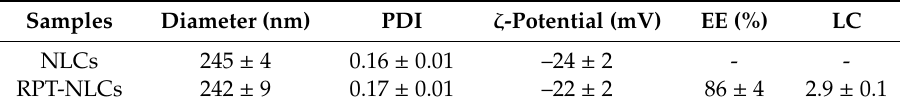
Table 5. Characterization of the optimized RPT-loaded NLCs and corresponding placebos (n = 3) in terms of mean hydrodynamic particle size, polydispersity index, zeta potential, encapsulation efficiency, and loading capacity.